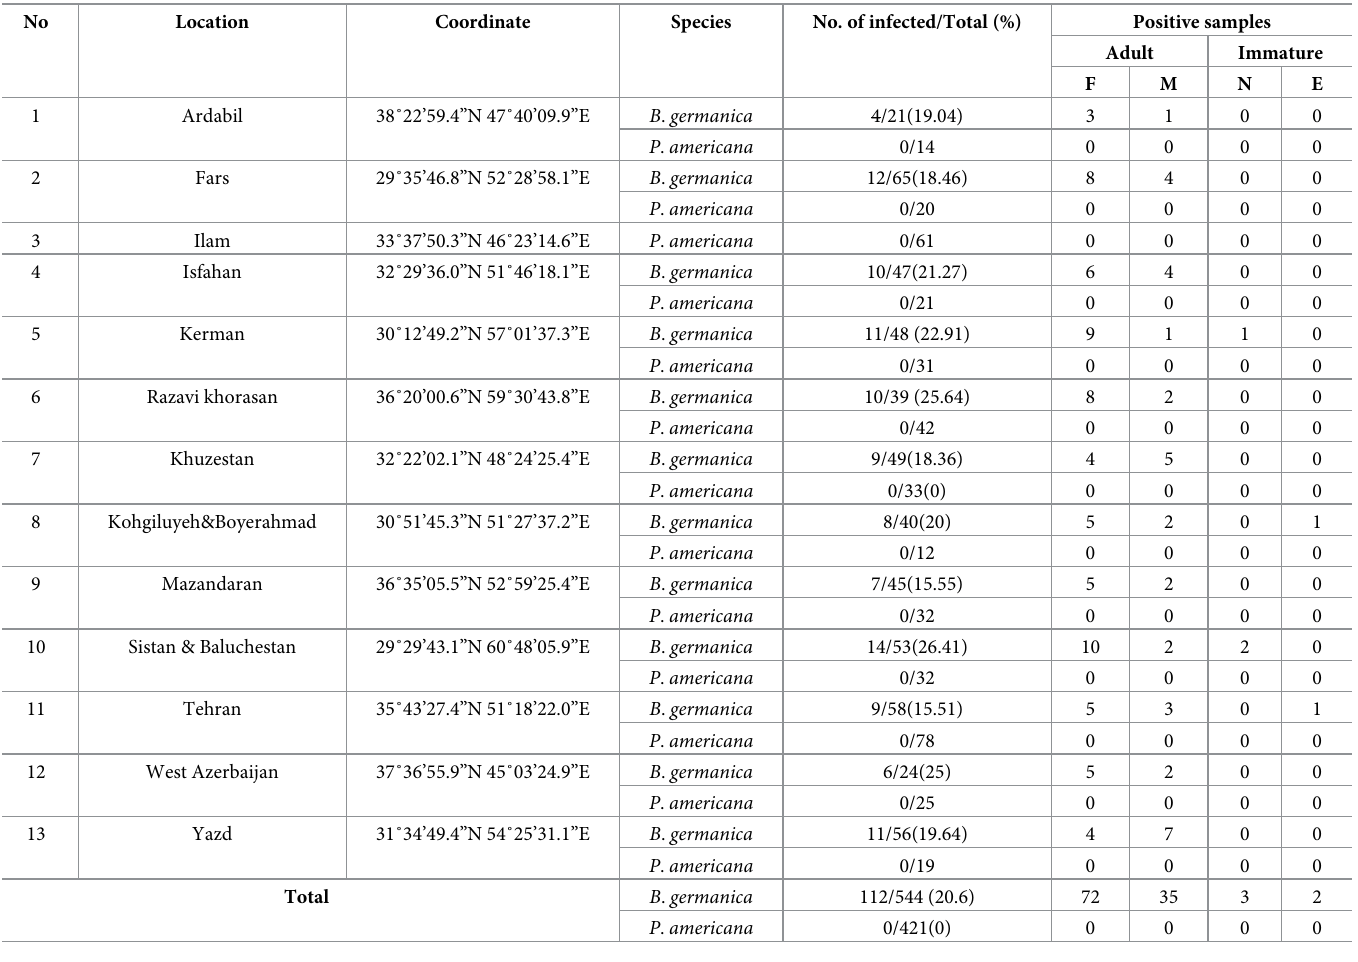
Table 3. Prevalence of Wolbachia infection in cockroaches collected from different localities of